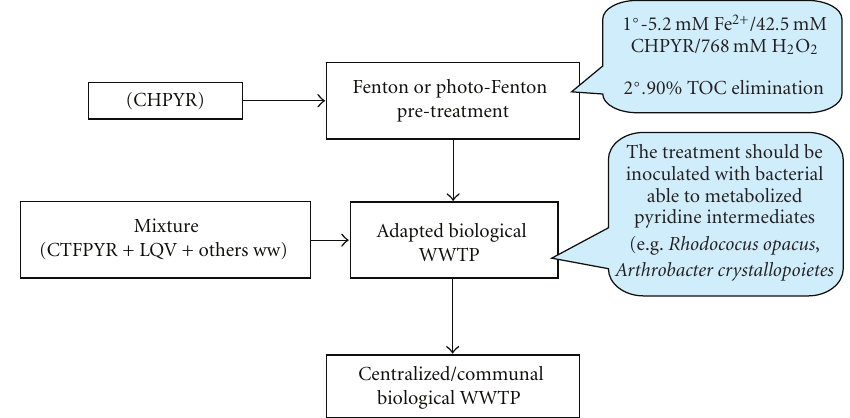
Figure 8: A proposed scheme of a diagram for the management of the studied e ffl uents.